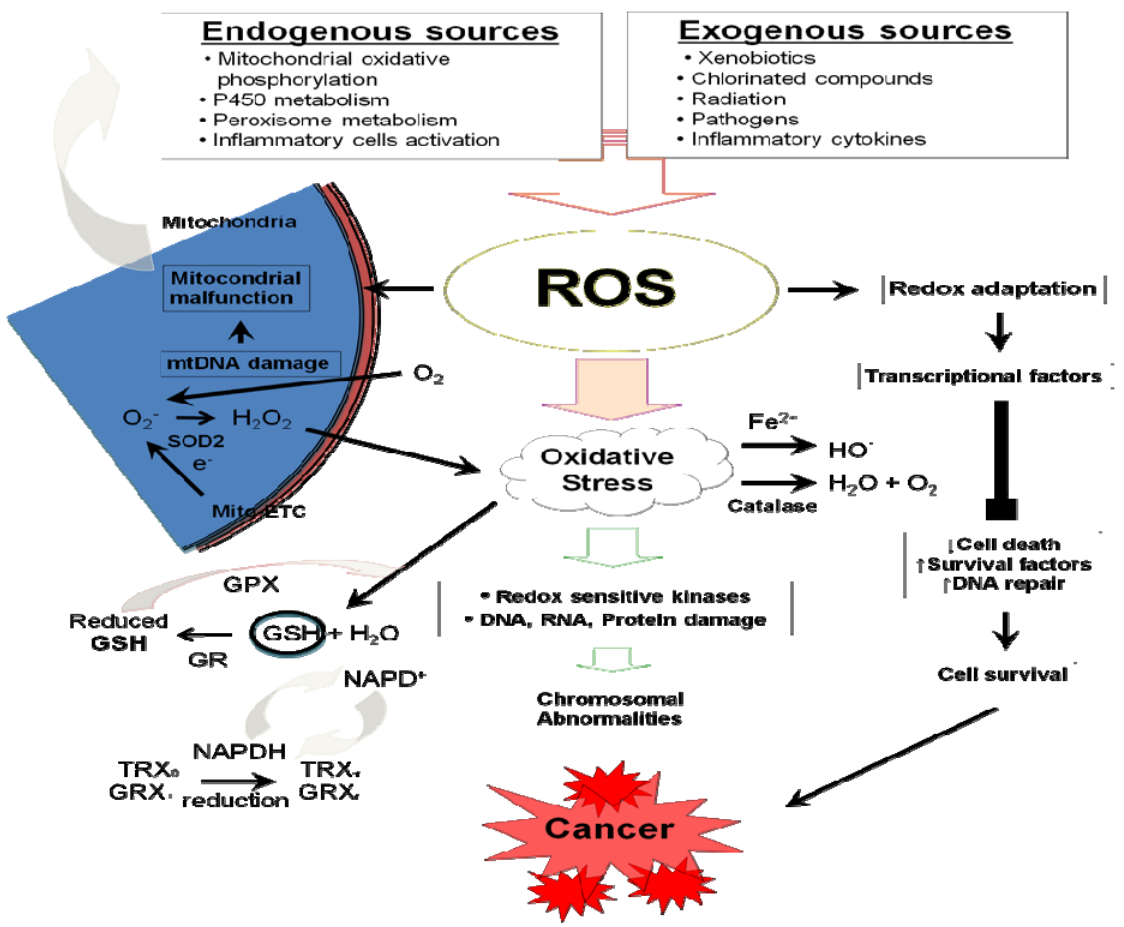
Figure 1 . The signaling pathways induced by oxidative